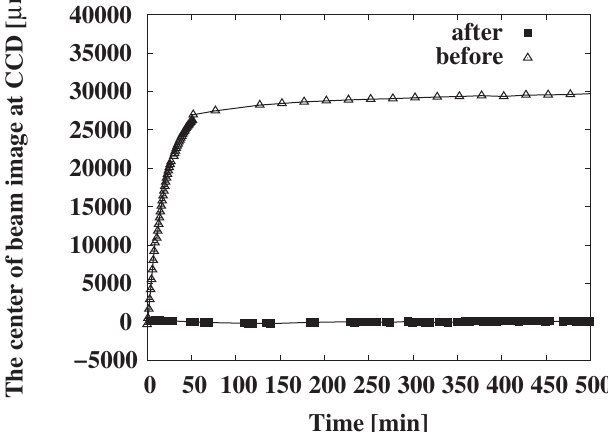
FIG. 4. Measurements of the long-term drift of the Si mono- chromator. The horizontal axis shows the elapsed time (minutes) and the vertical axis shows the measured vertical center of the beam image. The open triangles (solid squares) show the mea- sured vertical center of the beam image before (after) the Si crystal monochromator was upgraded.